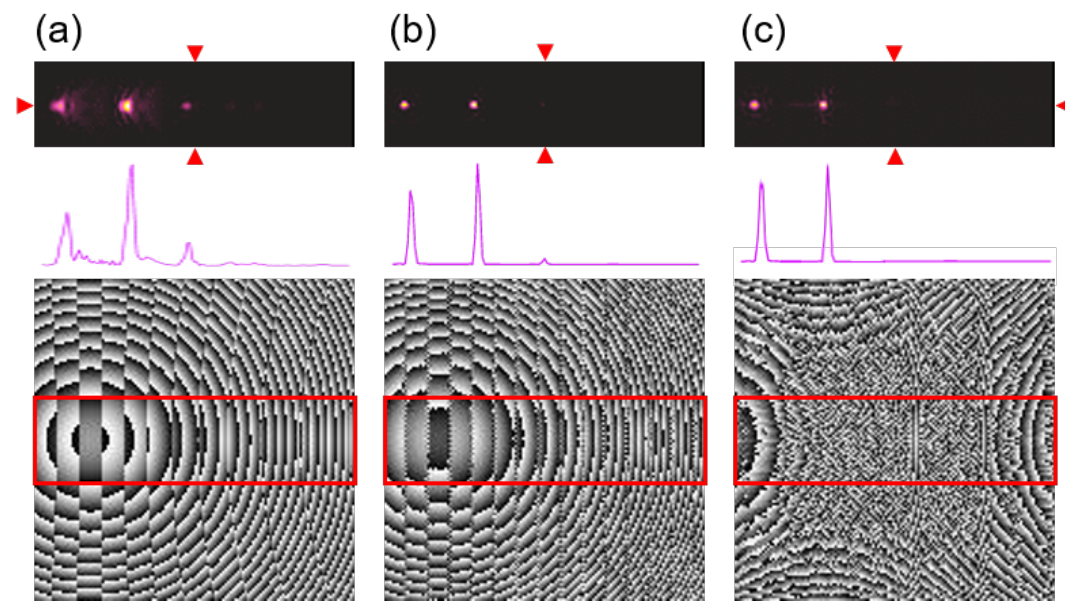
Figure 9. The comparison of different DOE design methods—( a ) theoretical off-axis lens equations with 25 mm and 50 mm shifts, ( b ) iterative algorithm and ( c ) neural network optimization of phase distribution. The calculated phase distributions of the diffractive structures are shown as a grey scale image (lower panel) corresponding to introducing phase retardation from 0 (black) to 2 π (white). On the upper panel the corresponding reconstructed intensity patterns are given in color palette. The reconstructed area was the same size as the structure, but here was limited to the region marked with red rectangles on phase retardation maps. The cross-sections along the horizontal axis crossing the main optical axis (marked with red triangles) are shown in the middle